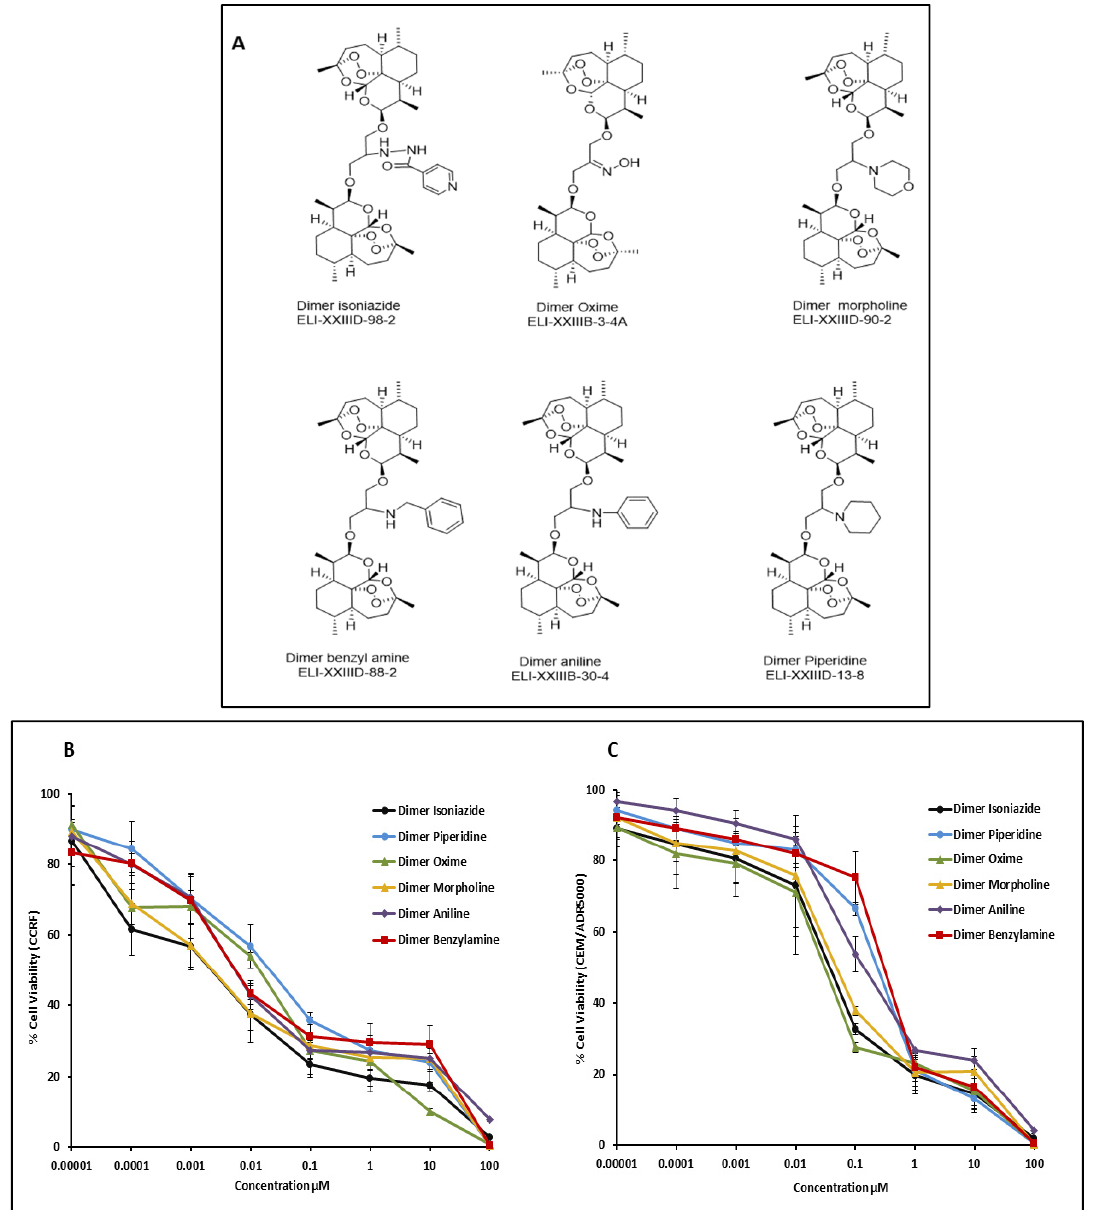
Figure 1. ( A ) Chemical structures of artemisinin dimers. ( B ) Growth inhibitory activity of six artemisinin dimers towards CCRF-CEM leukemia cells. ( C ) Growth inhibitory activity of six artemisinin dimers towards multidrug-resistant CEM/ADR5000 cells. Data are expressed as mean values ± SD of three independent experiments.